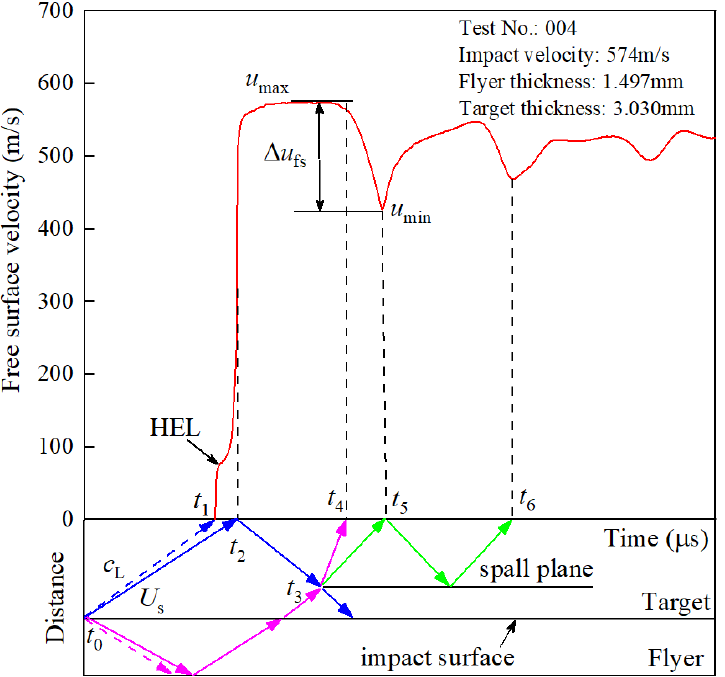
Figure 3. Representative free surface velocity in test No. 004 under impact loading.